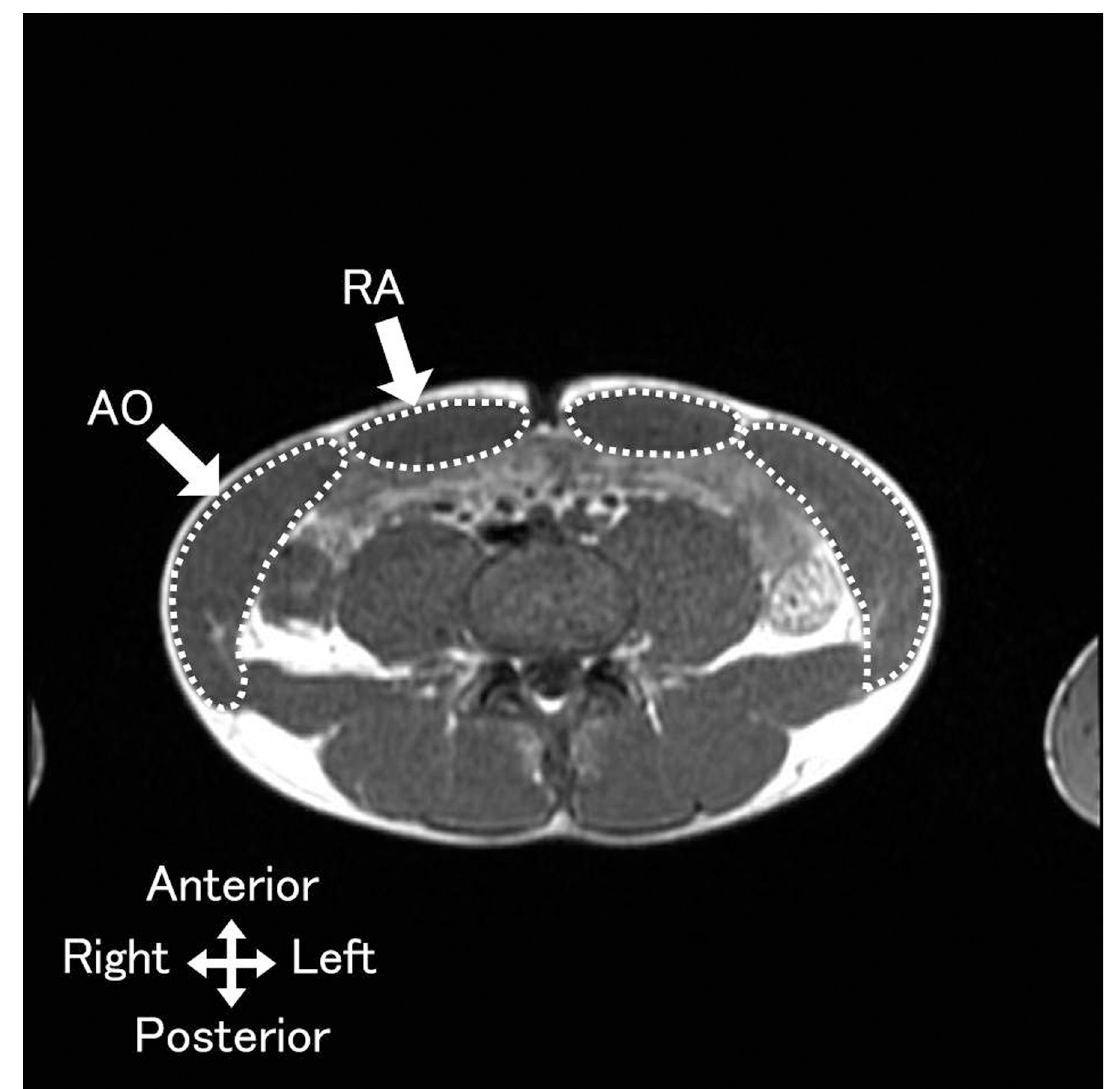
Fig 1. A typical magnetic resonance image of the trunk. The white broken lines are the borders of muscles. RA, rectus abdominis; AO, abdominal oblique muscles (internal and external obliques and transversus abdominis). for each slice by a person who was blinded to the group allocation. The mean of the two traced values was calculated, and the overall mean of the left and right sides of each muscle was used for subsequent analyses. The mean coefficient of variation (CV) for the two CSA measure- ments was 0.8 ± 0.5% and 0.4 ± 0.3% for RA and AO, respectively. Intraclass correlation coeffi- cient (ICC {1, 2}) of the measurements was 0.999 for both RA and AO.